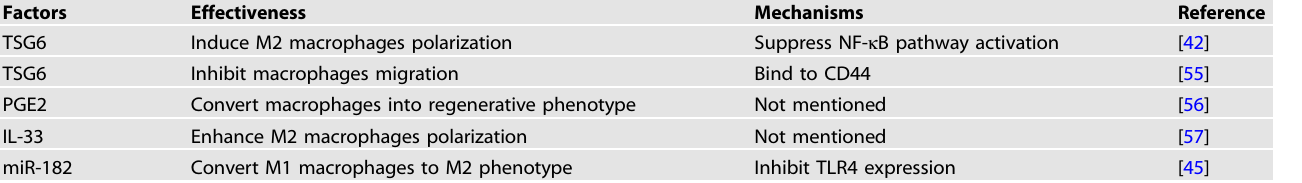
Table 2. Paracrine effectors of MSCs in the regulation of macrophage